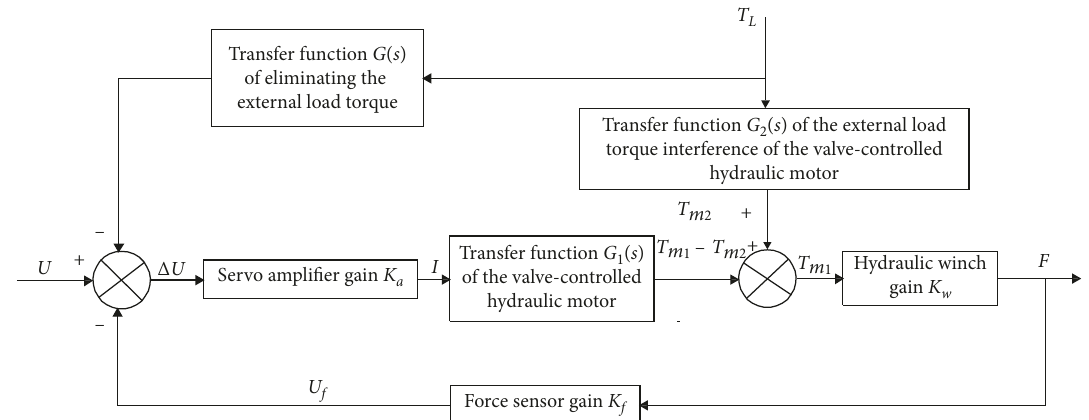
Figure 3: The control process block diagram of the feed-forward compensation corrected